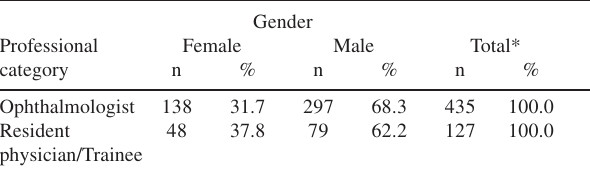
Table 2 - Professional category and gender